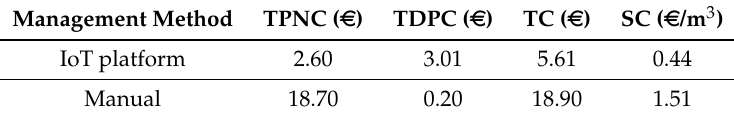
Table 2. Comparative operating cost results. TPNCis the total operating cost associated to the water coming from the public utility network; TDPCis the total operating cost of the desalination facility; TC is the Total Cost; and SC is the Specific Cost, that is the cost per unit of water demanded in the agroindustrial